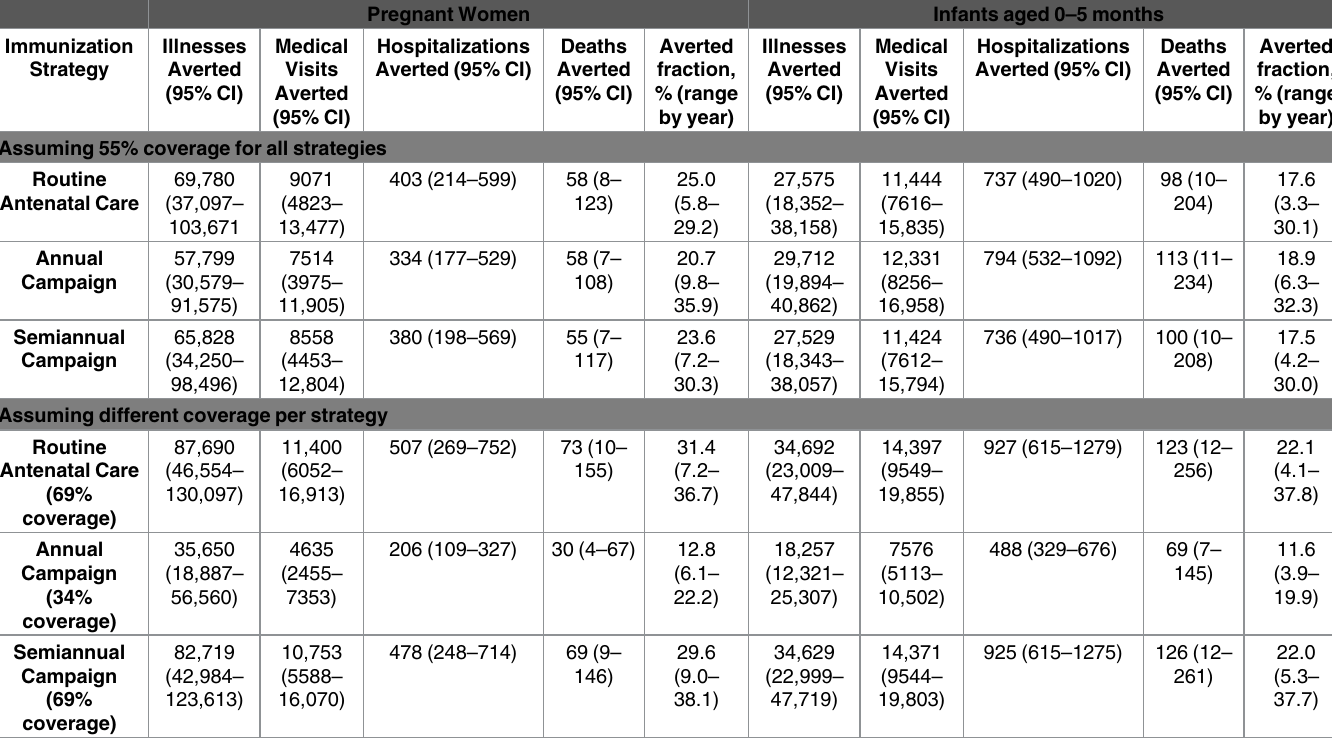
Table 3. Comparison of influenza-associated disease burden potentially avertedthrough different maternal immunization strategies, Kenya,